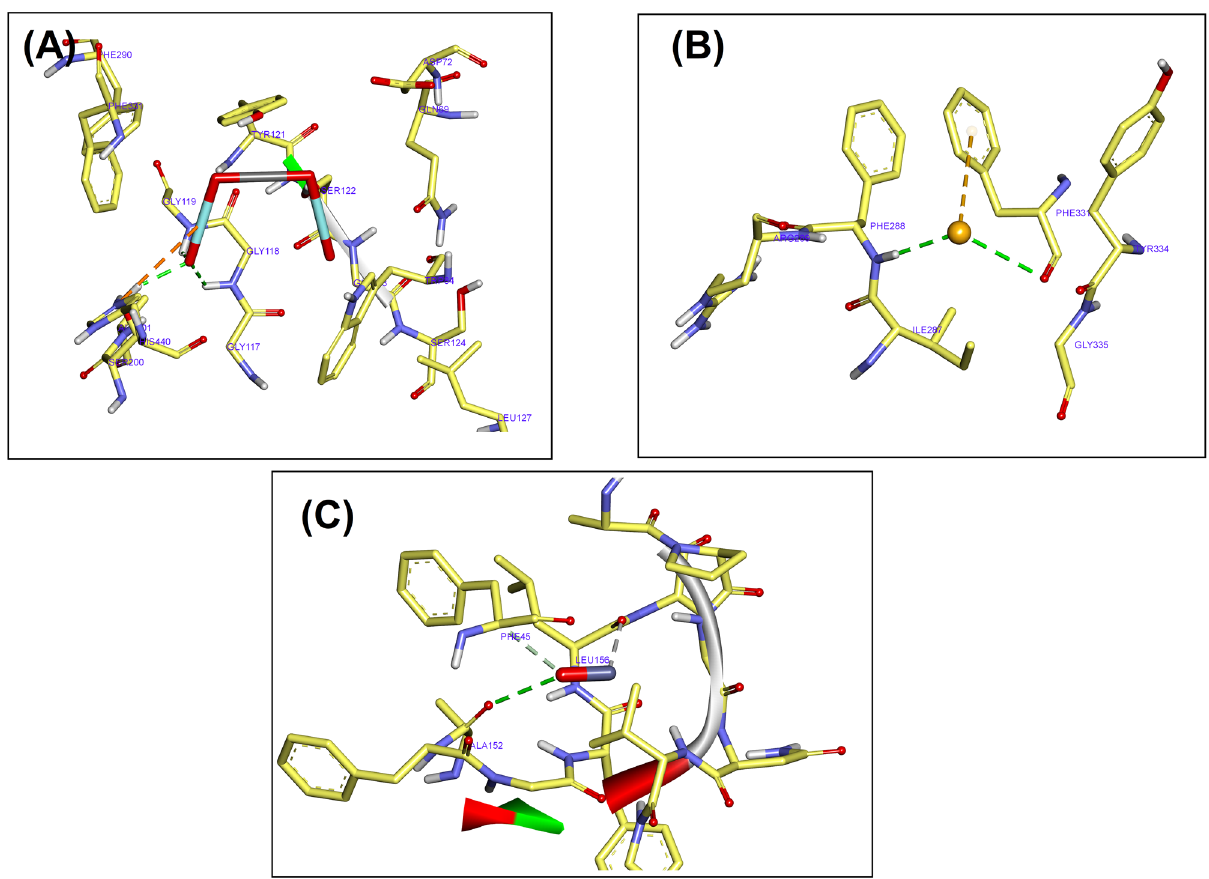
Figure 4. Docking conformation of CoFeNPs ( A ), SeNPs ( B ), and ZnONPs ( C ) in the active site of acetylcholinesterase and ZnONPs in inhibiting the LPS-induced production of NO in a dose-dependent manner. Accordingly, the recorded potentials of the three types of NPs in this study will open the door for their in vivo clinical evaluation.